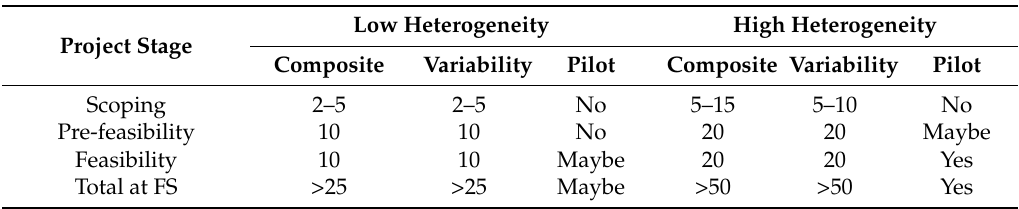
Table 11. General recommendation for the number of metallurgical recovery samples (composite, variability and pilot/trial) for different project stages based on gold deposit heterogeneity. Numbers of samples per metallurgical type/domain. Any one composite may yield a number of tests depending on sample mass and project need.